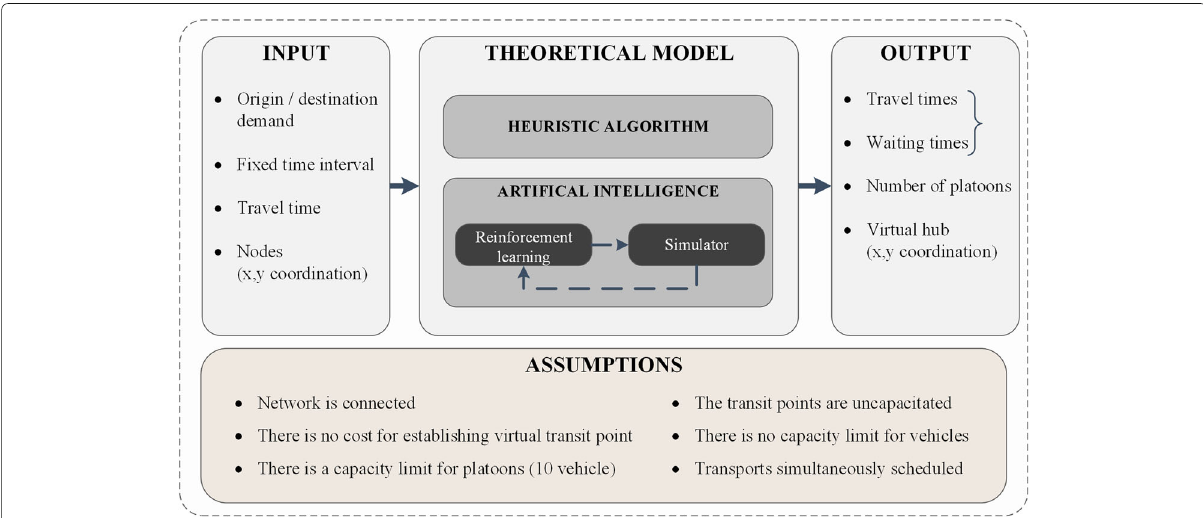
Fig. 2 Theoretical model. Theoretical model for virtual transfer point optimization in Physical Internet network (based on [24])